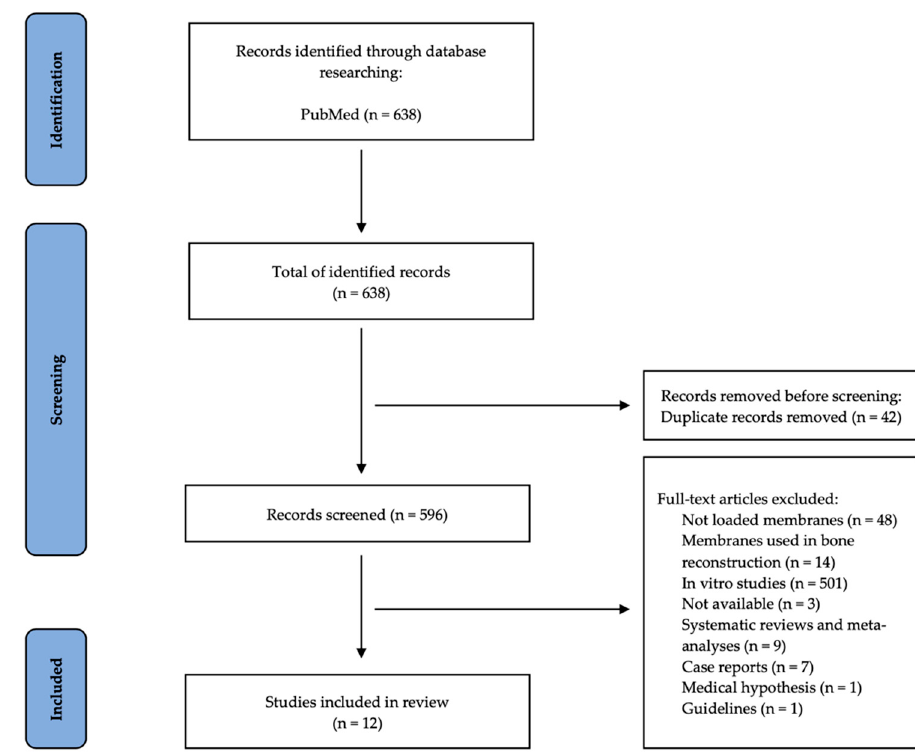
Figure 1. PRISMA Flow Diagram—selection of the included studies.